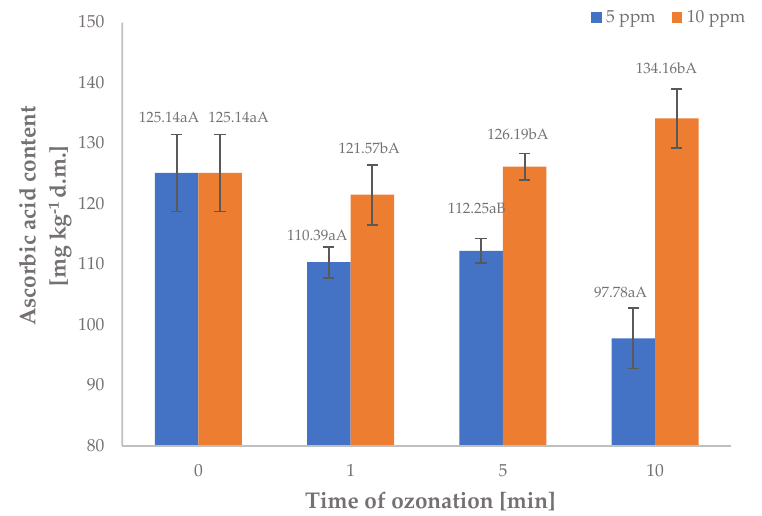
Figure 3. Ascorbic acid content in Kalanchoe daigremontiana leaves depending on the duration of ozone treatment (n = 20): differences between the results for duration of ozone treatment on specific days are marked with small letters, and differences between dose of ozone (ppm) measurements are marked with capital letters; significance level is defined as p < 0.05.